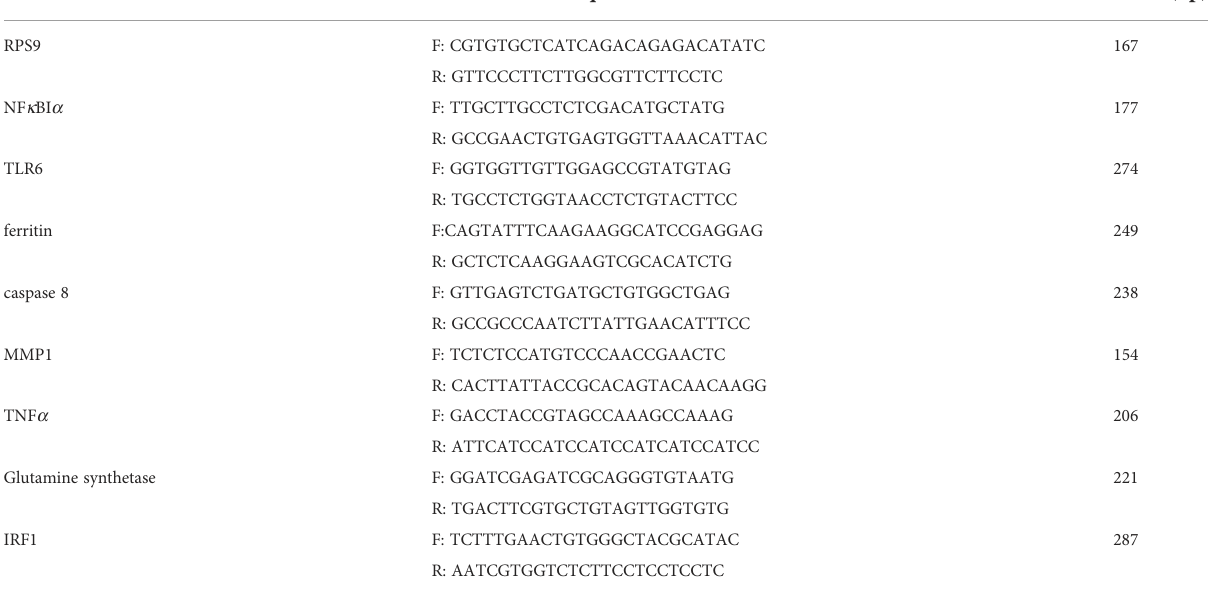
TABLE 1 Primers used for veri fi cation of DEGs in real-time PCR.